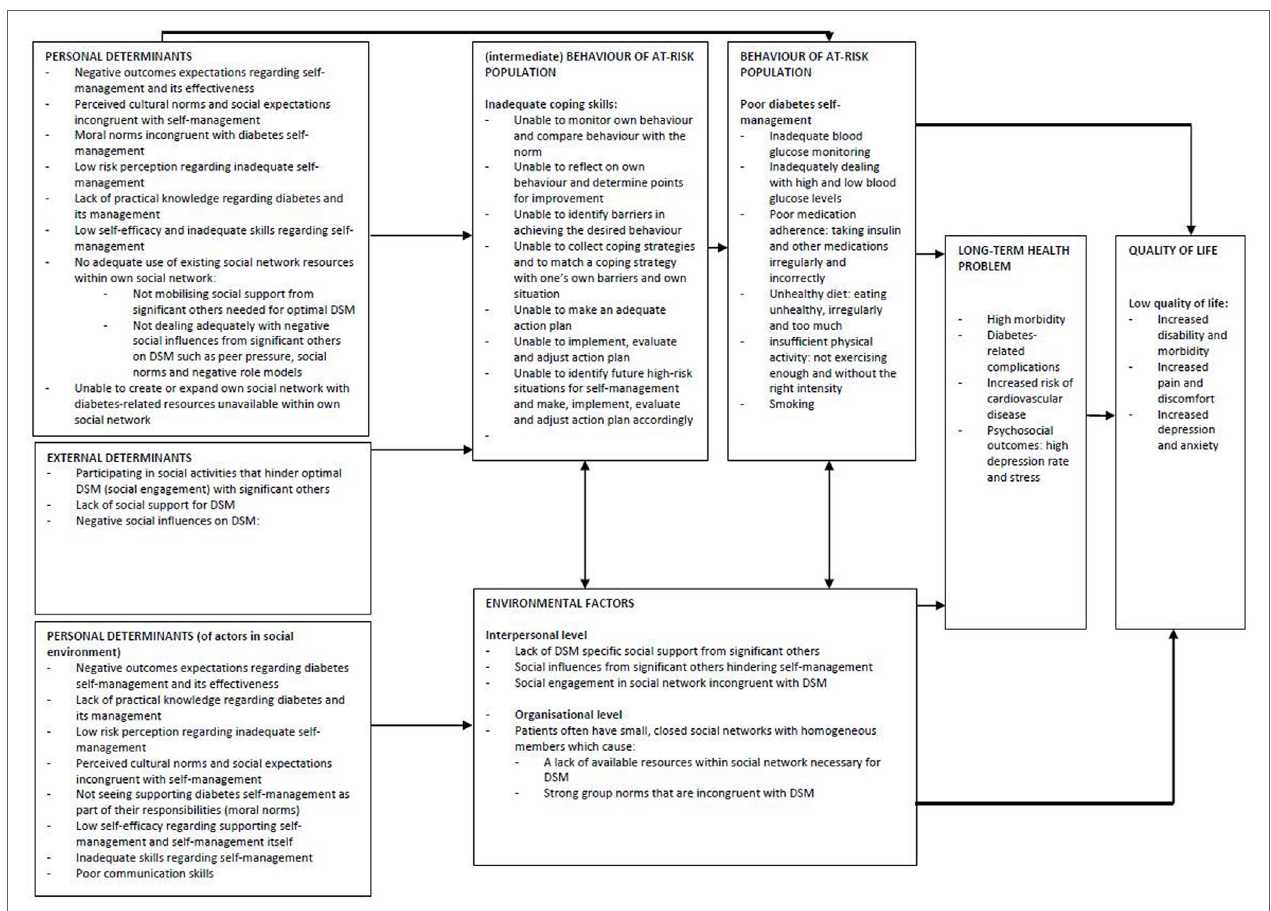
FigUre 1 | Results of the needs assessment: the logic model.